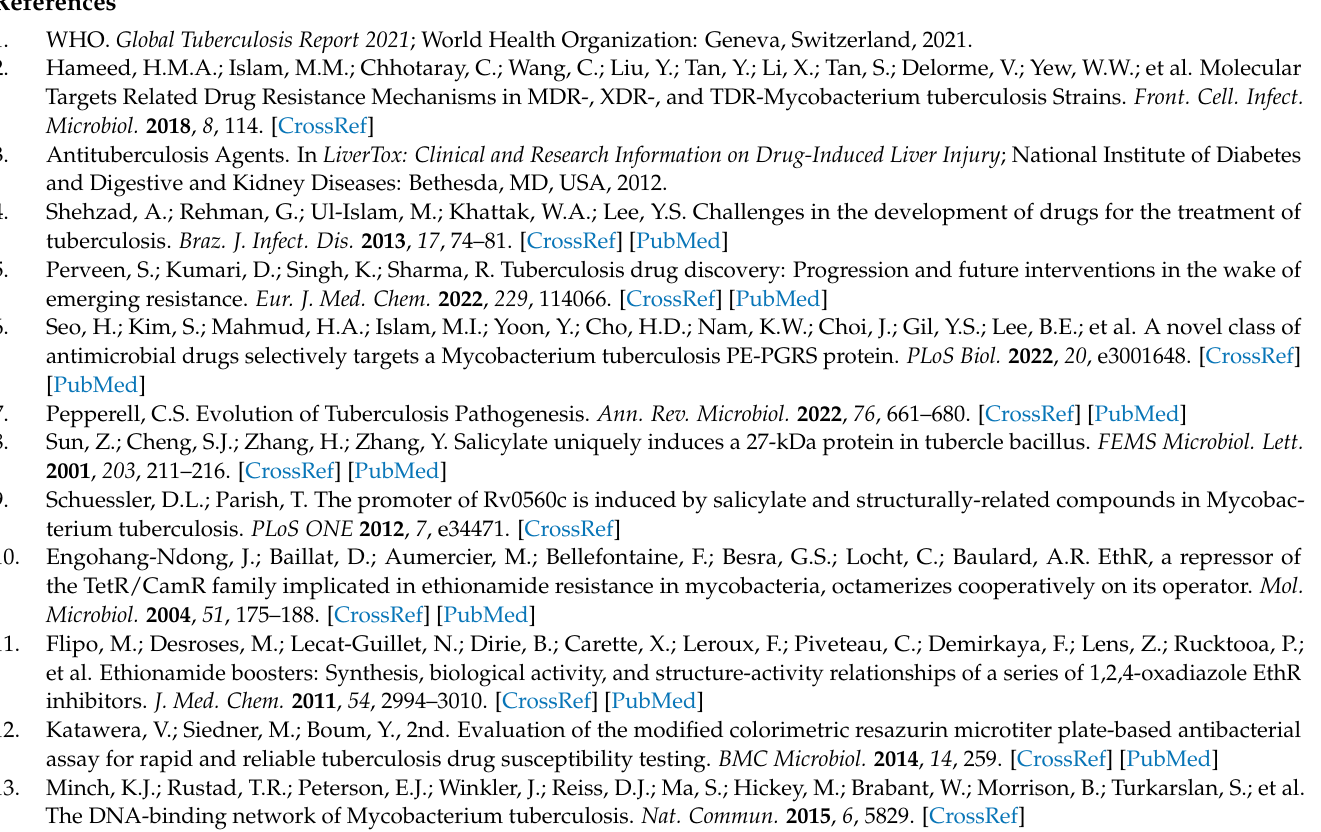
protein, Figure S7: Synthesis of Rv0560c protein, Supplementary method: Synthesis of Rv3855 protein, Synthesis of Rv2887 protein, Synthesis of Rv0560c protein, Preparation of rabbit polyclonal antisera against Rv0560c protein, Microarray,